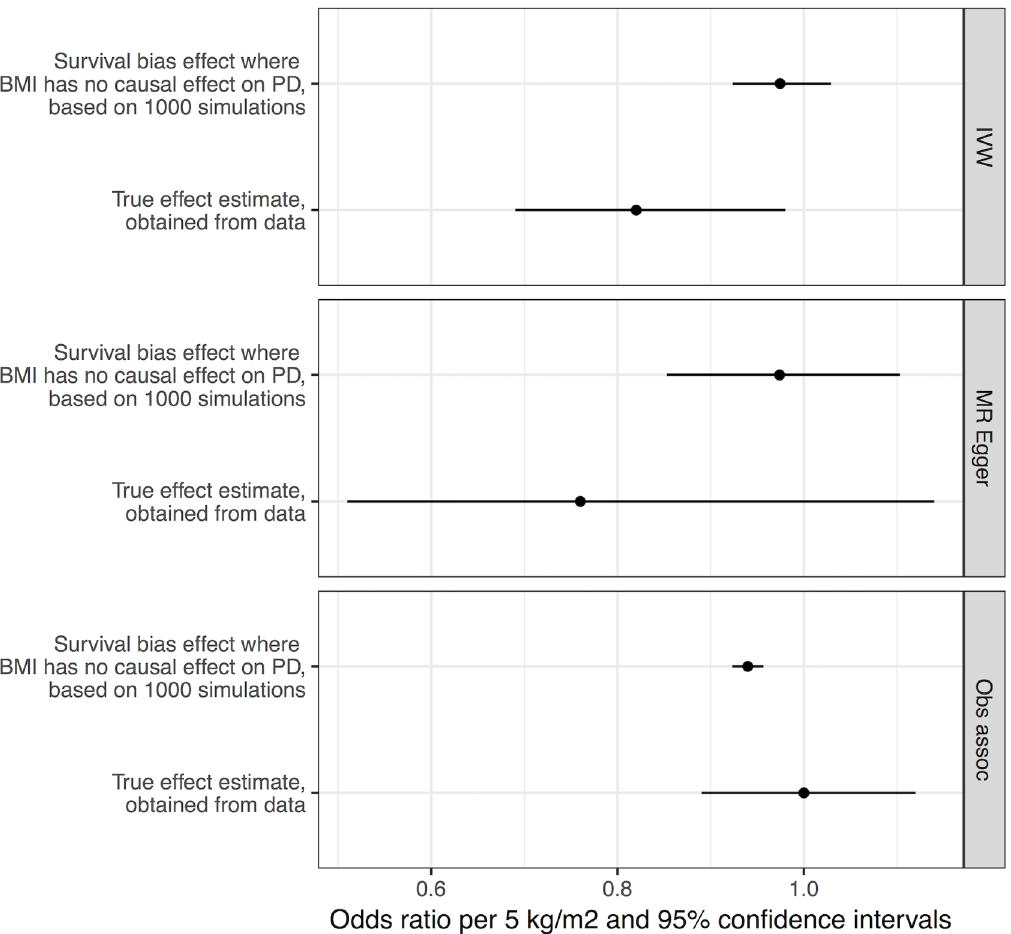
Fig 3. Frailty analysis. We obtained effect estimates from two sources: (1) analysisof the causal influence of BMI on PD using real data and (2) simulations where BMI had no effect on PD, and any apparenteffect was due to survival bias alone. This figure shows the comparisonof the estimates from these two sources using three different approaches—MR IVW analysis, MR–Eggerregression,and observational associations.For the true effect estimates, the horizontallines denotethe 95% confidenceintervals; for the results from simulations, the horizontallines denote 95% confidenceintervals obtained from 1,000 simulations. BMI, body mass index; IVW, inverse-variance weighted; MR, Mendelianrandomisation; PD,